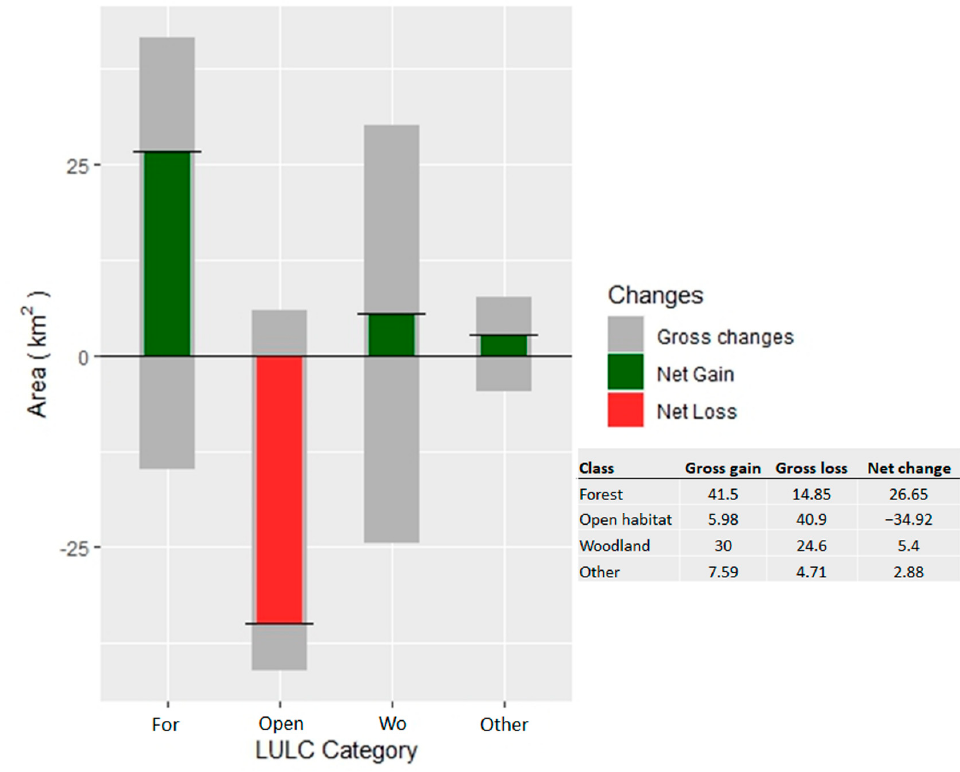
Figure 4. Net and gross LULC changes in km 2 for the overall study period (1945–2015). For: Forest, Wo: Woodland, Open: Open habitat, Other: urban, water and rock land cover